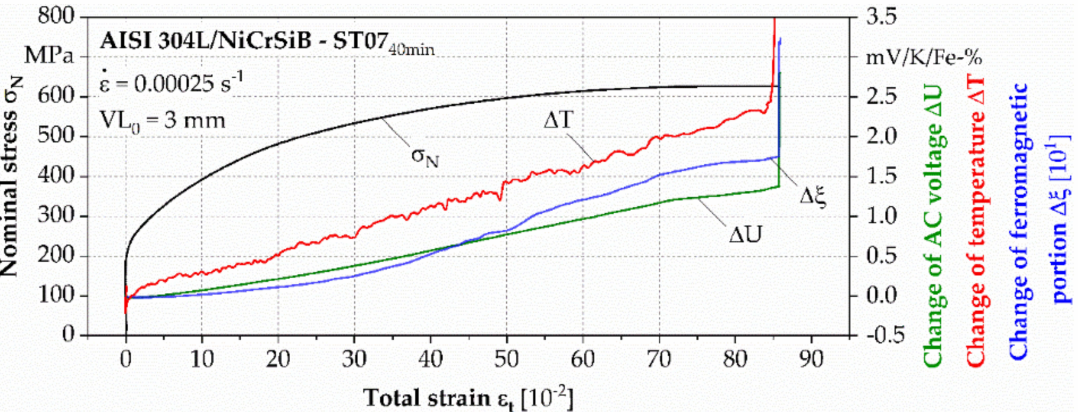
Figure 15. Instrumented low-strain tensile test with ST07 40min